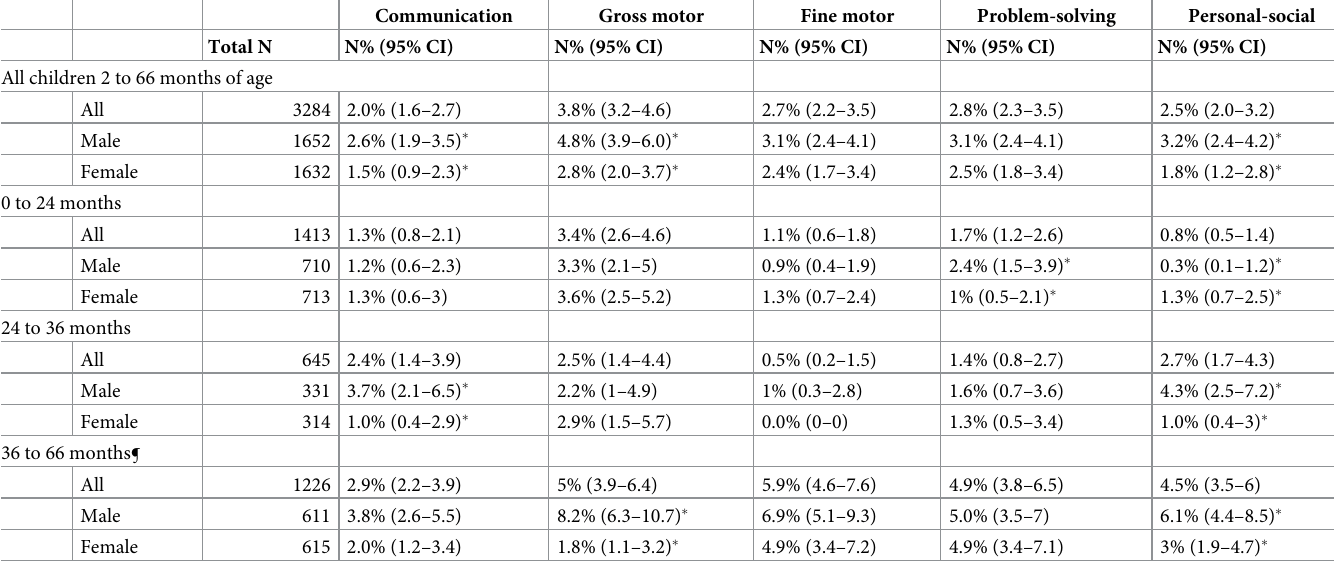
Table 2. Population prevalence of development delay by Ages and Stages Questionnaire domain, child age, and child sex in Ceara´, Brazil.